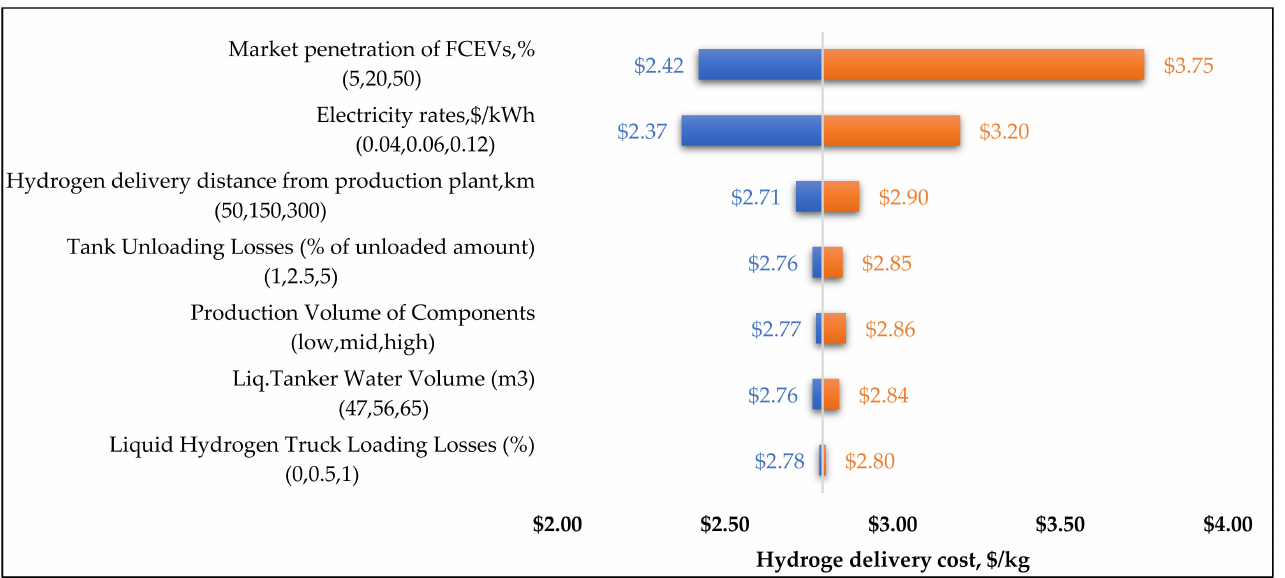
Figure 13. Range of gaseous tube trailer delivery costs to a 1.5 tpd refueling station.